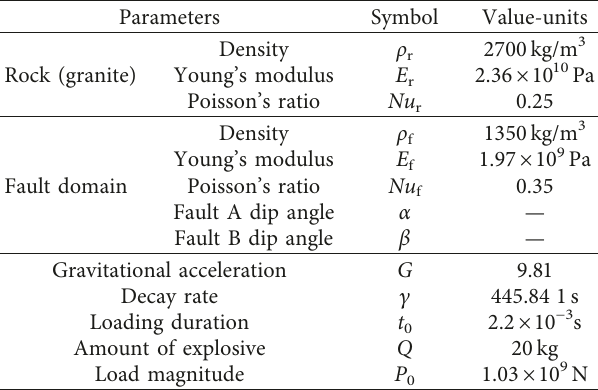
Table 2: Detailed parameters used in numerical modeling.